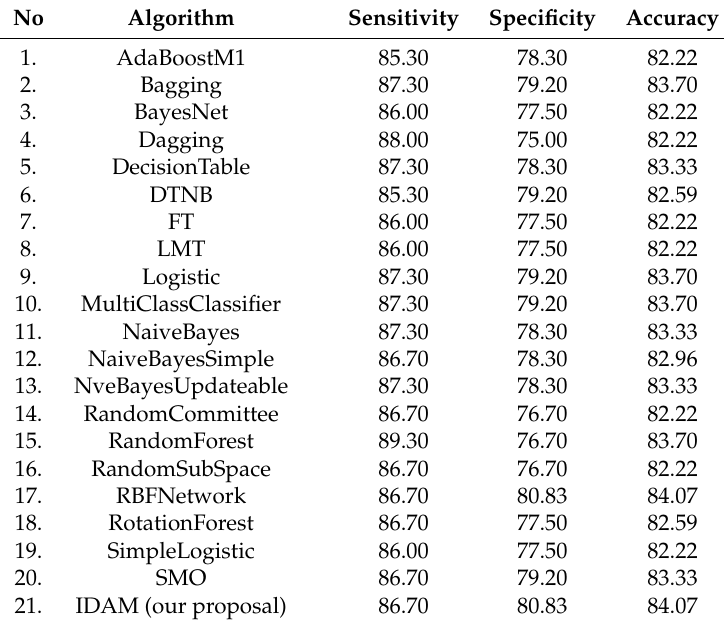
Table 1. Classification accuracy using Heart Disease Dataset. Algorithms are presented in alphabetical order.